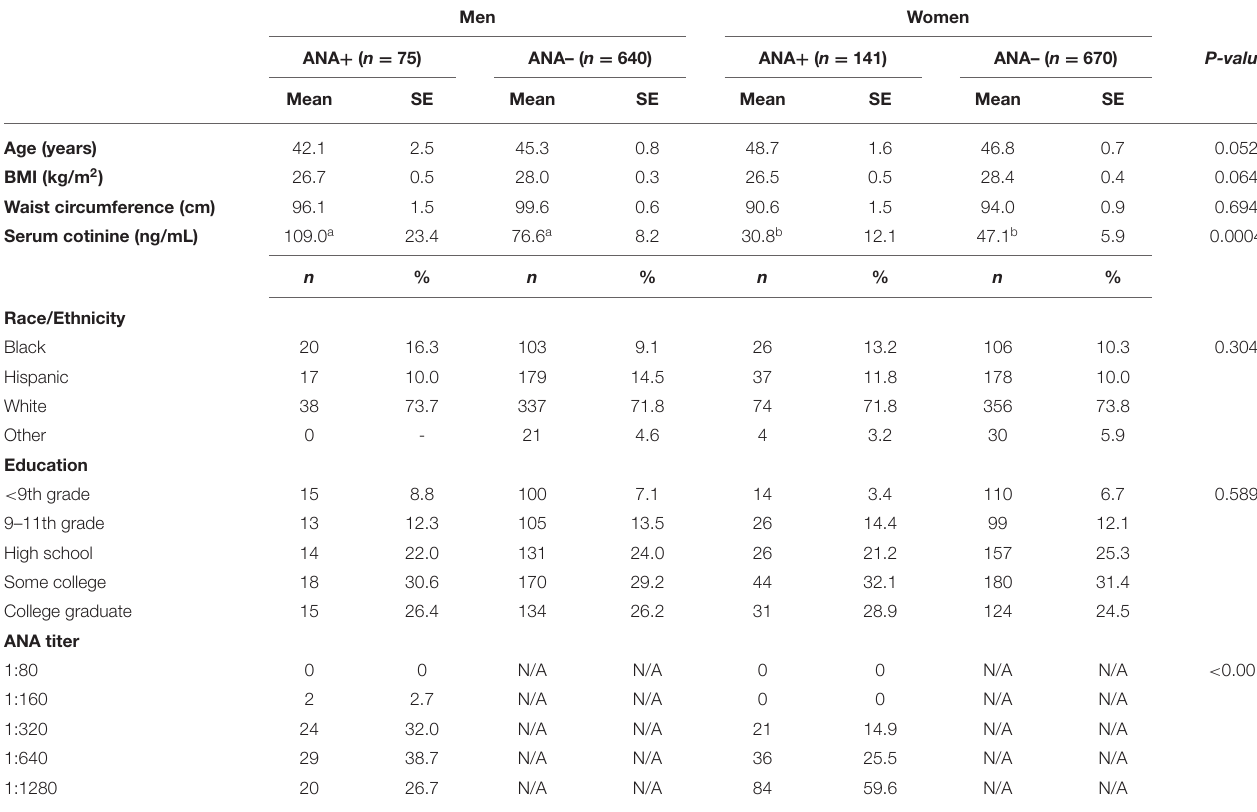
TABLE 1 | Descriptive statistics of men and women in NHANES 1999–2004 ( n =